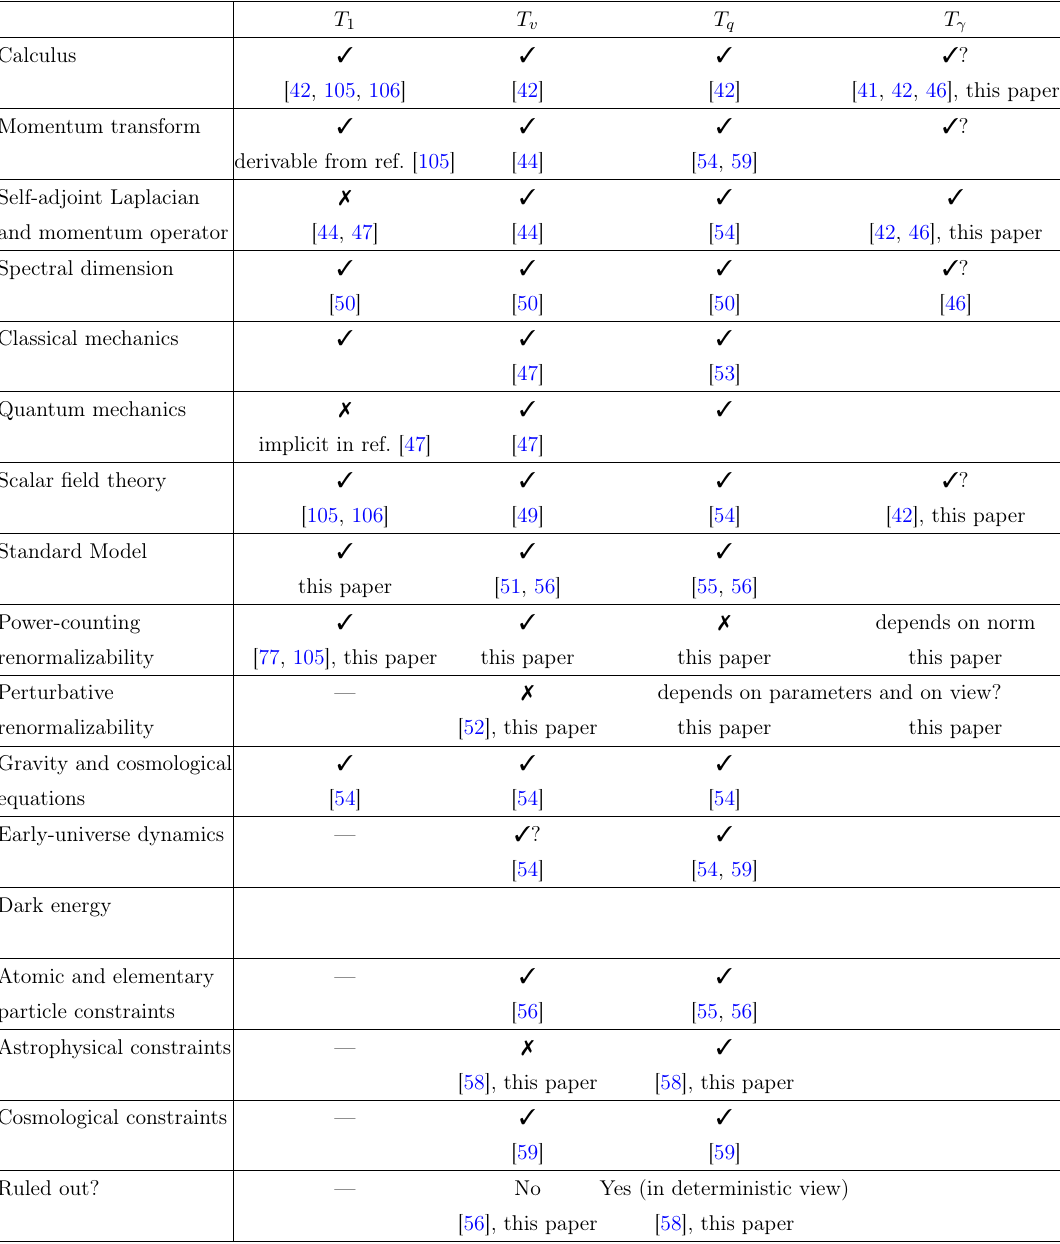
Table 9 . Status of the multifractional model T 1 and of the three multifractional theories T v;q;(cid:13) . Empty cells correspond to topics not studied yet. Items with a question mark “?” indicate partial results. If an nonempty item (with or without question mark) has no references given, the result is either obvious (no question mark) or easily doable (with question mark). The items “—” for T 1 are not of interest for the future since T 1 is a toy model replaced by T v ; however, one could still do some cosmological phenomenology with